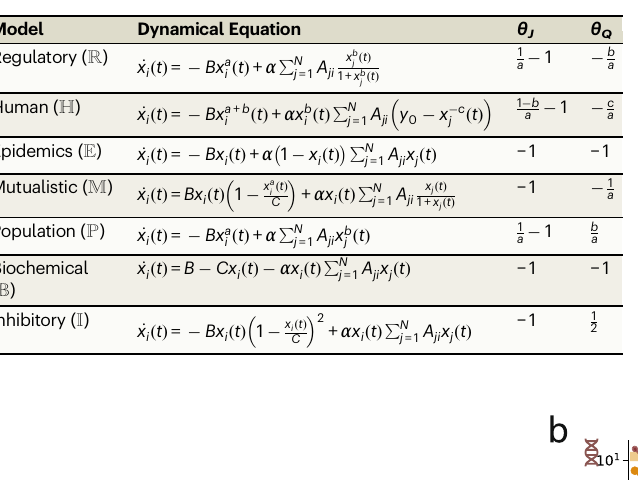
(cid:2) 1 and θ (cid:2) b <0) and Q = a a